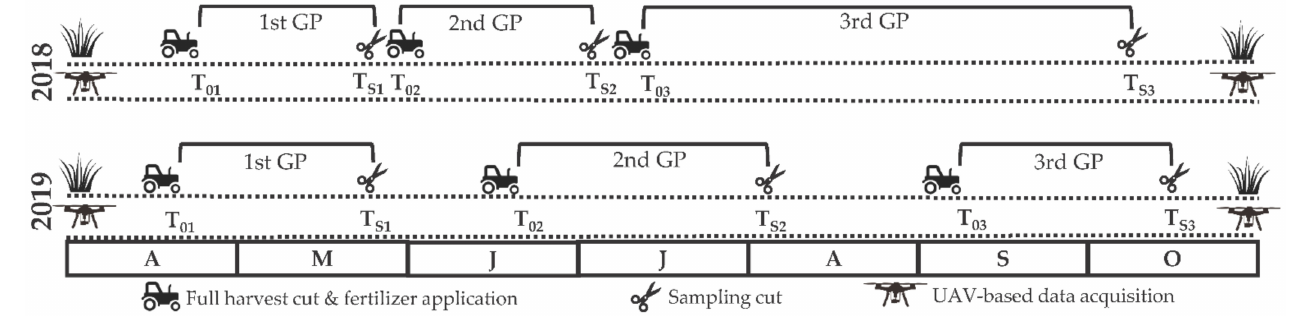
Figure 6. Schematic overview of sampling dates for UAV-based data acquisition and destructive biomass sampling. T 0 : base model after equalization cut, T s : sampling date, GP: growing period.